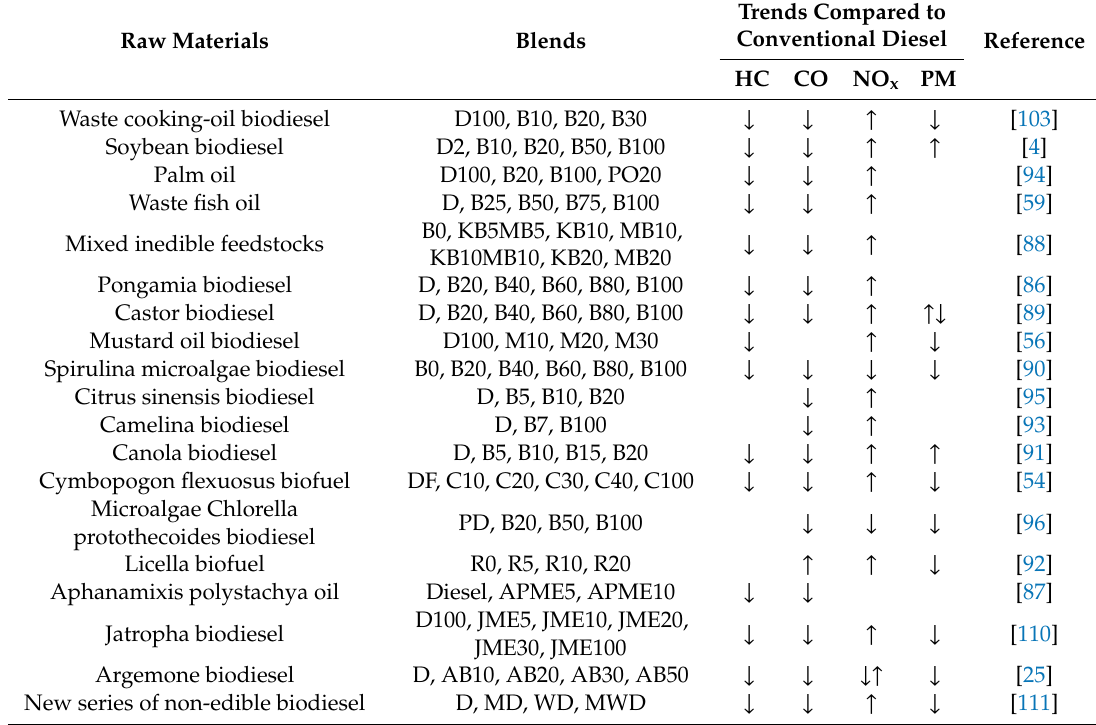
Table 3. Emission characteristics of different fuels with biodiesel. (“ ↑ ” means the emissions increase, “ ↓ ” means the emissions decrease, and “ ↑↓ ” means emissions vary with operating conditions). Trends Compared Raw Materials Blends